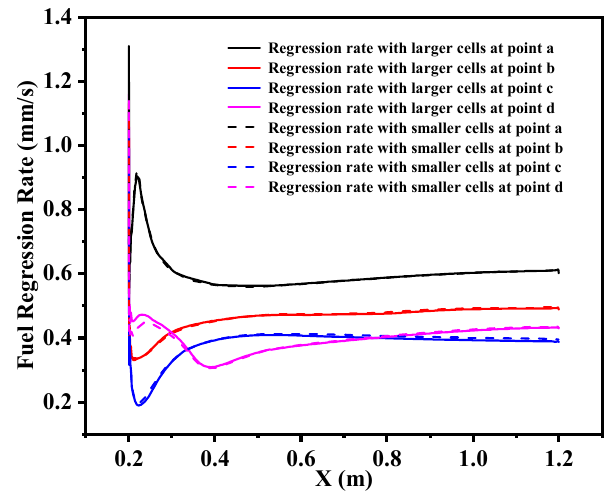
Figure 10. Fuel regression rate distributions with two kinds of CFD meshes.